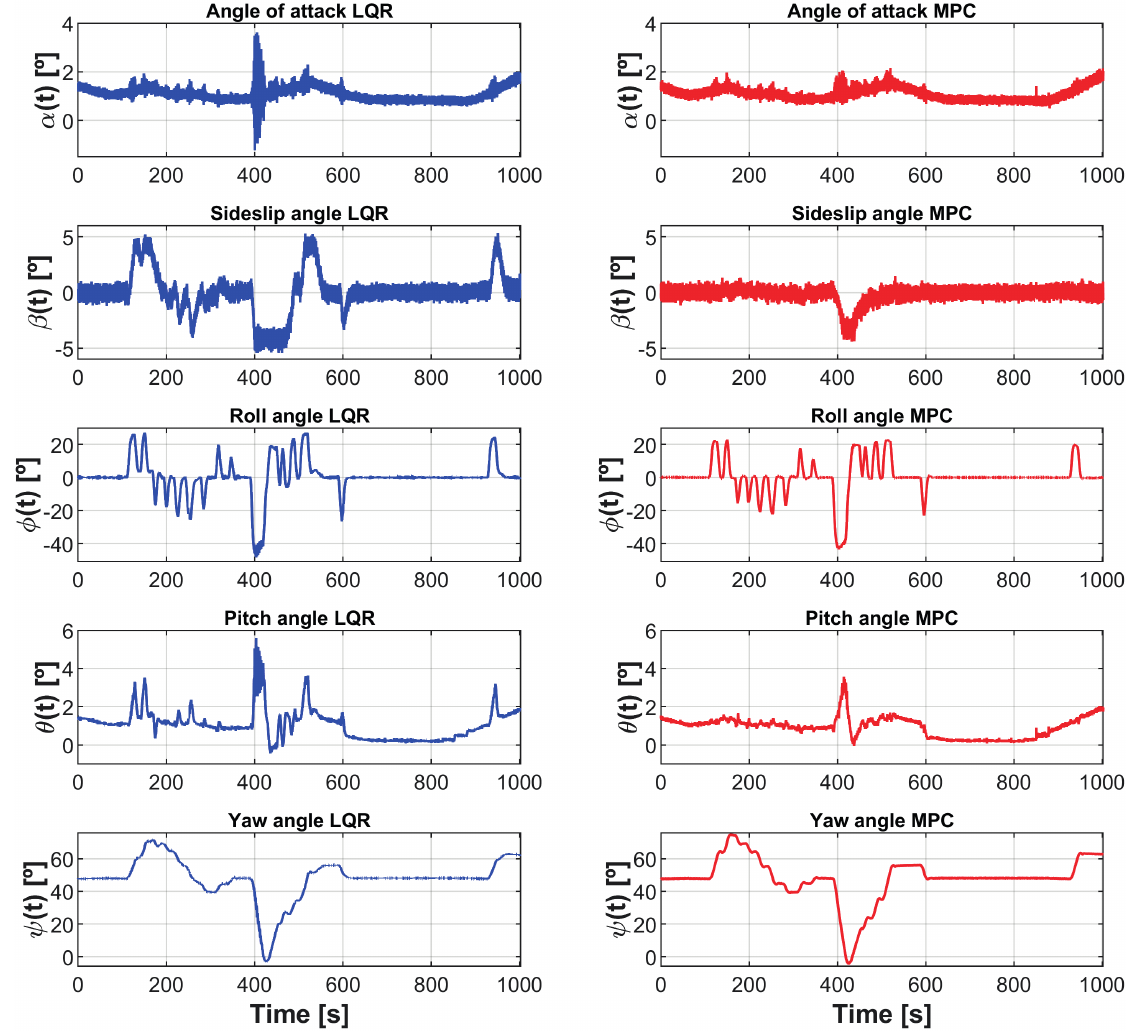
Figure 11. Principal flight parameters by LQR (blue) and MPC (red): the angle of attack ( α ), sideslip angle ( β ), and Euler angles ( φ , θ , ψ